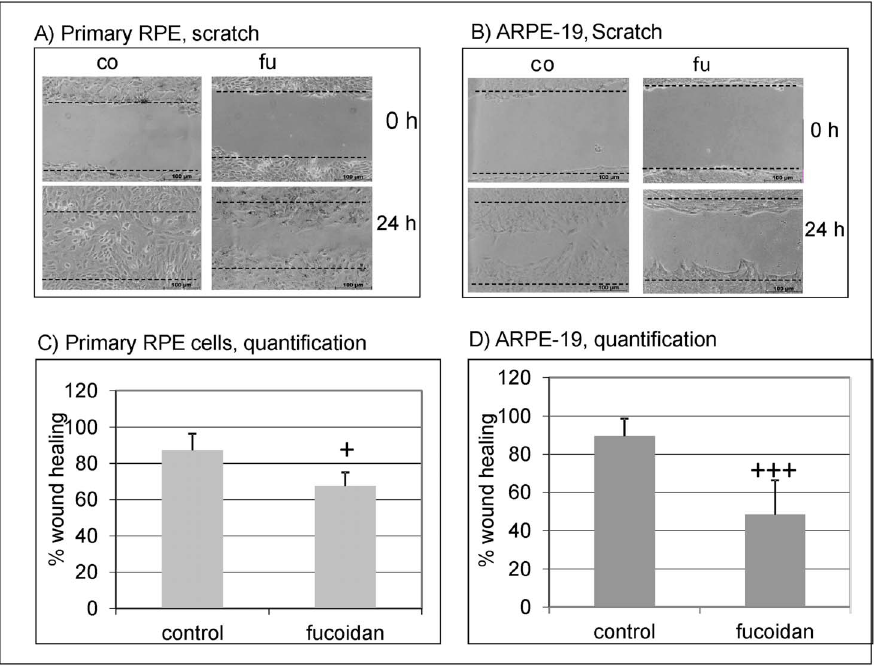
Figure 3. Wound healing. A wound was scratched in a confluent cell layer of primary porcine RPE cells and ARPE-19 cells. Cells were either untreated (control) or exposed to fucoidan (100 m g/ml) for 24 hours. Exemplary pictures of wound healing are depicted for primary RPE cells (A) and ARPE-19 cells (B). The percentage of coverage after 24 hours of wound healing is depicted in the graphs for primary RPE cells (C) and ARPE-19 cells (D). Fucoidan significantly reduces wound healing in both RPE and ARPE-19 cells. Significance was determined with student’s t-test, + p , 0.05; +++ p , 0.001.